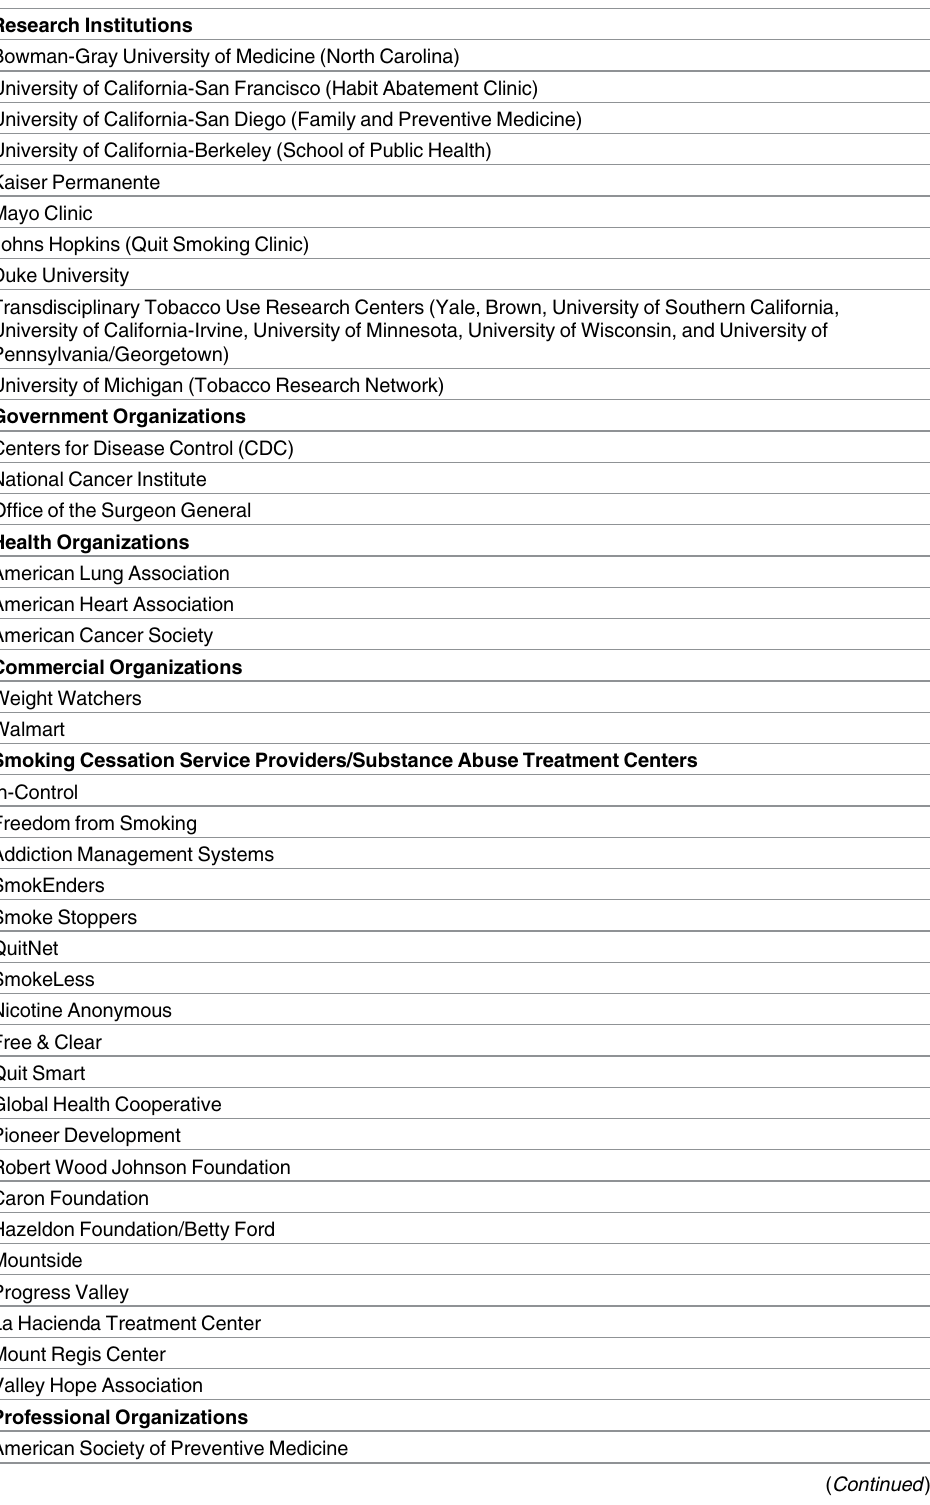
Table 3. Organizations and individuals identified by Philip Morris USA’s Cessation Exploration Team as potential smoking cessation program partners or “engagement candidates.” [97, 101, 107, 110, 111, 114,